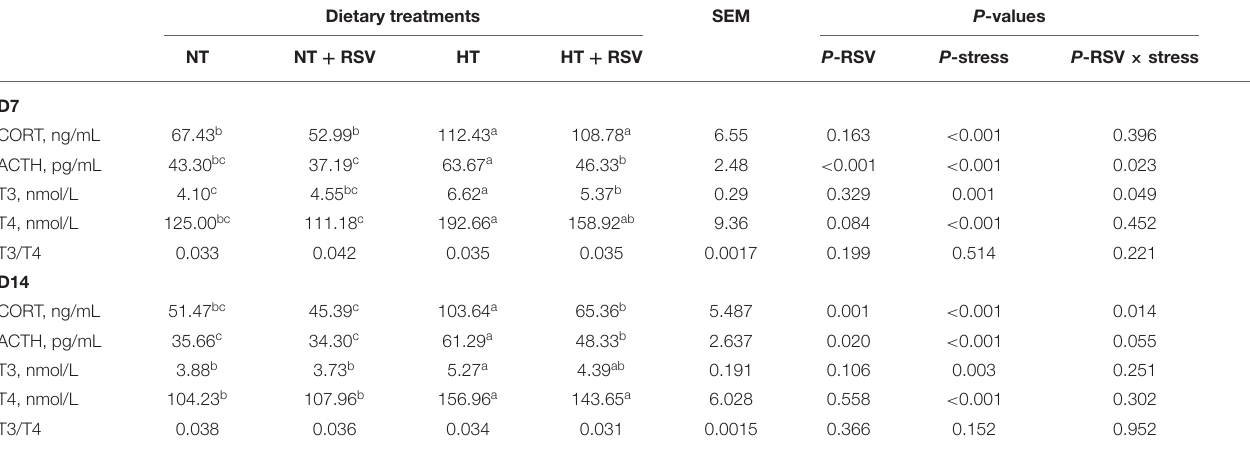
TABLE 4 | Effect of heat stress and RSV on the serum hormone concentration of 35-day-old and 42-day-old broilers (d 7 and 14 of heat treatment). Dietary treatments SEM P -values NT NT + RSV HT HT + RSV P -RSV P -stress P -RSV × stress